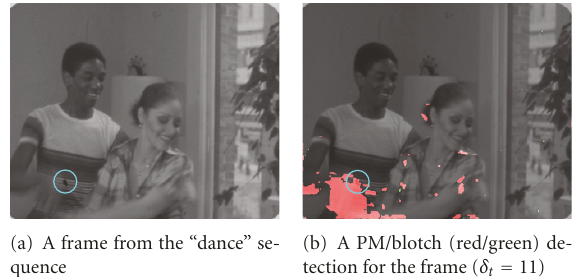
Figure 15: This blue circle in the two images highlights a blotch located near a region of motion blur. Due to its location the blotch is detected as PM by the proposed